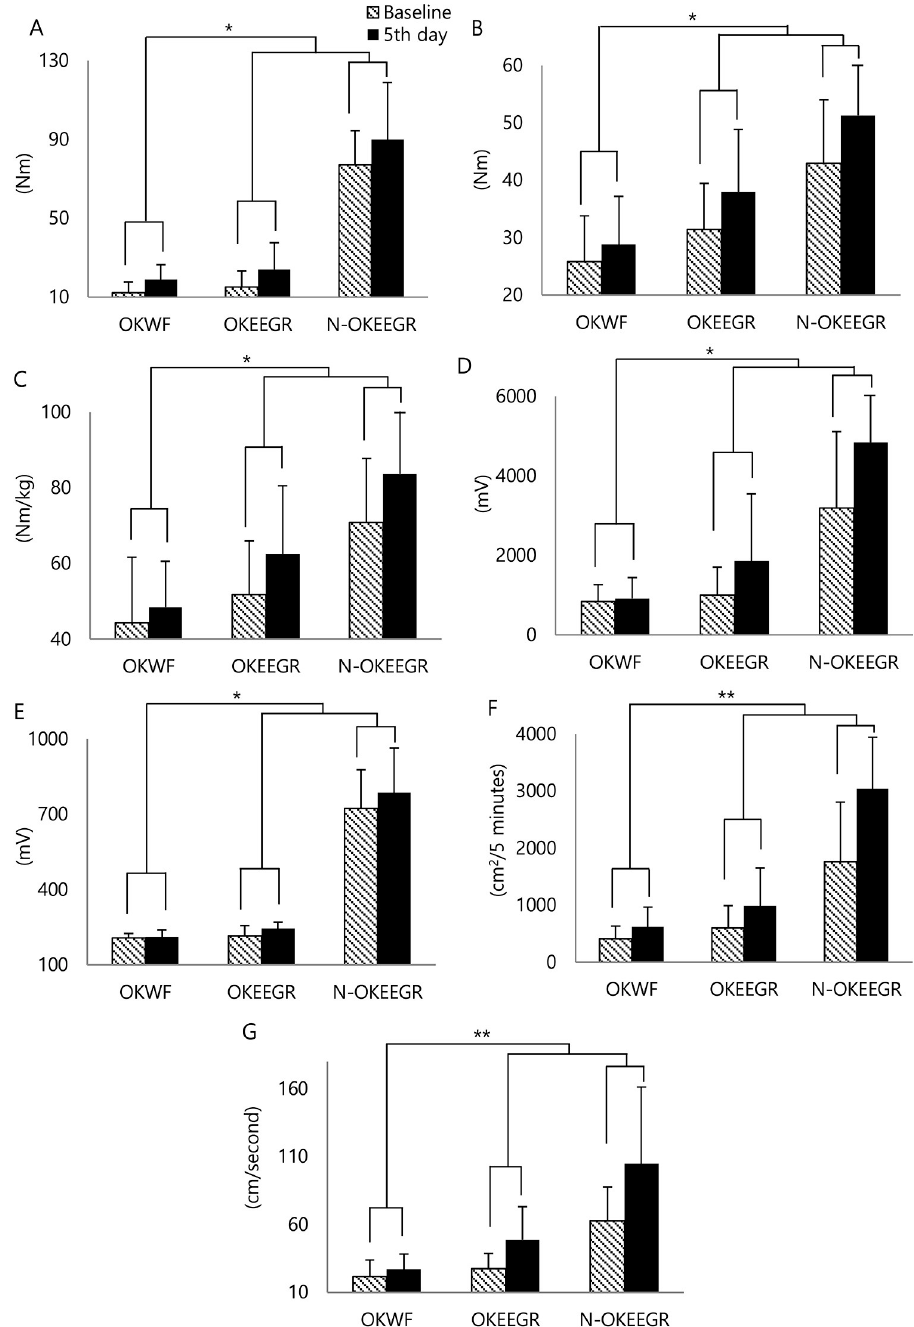
Fig 3. The peak torque and electromyographic muscle activation of knee flexors and extensors. Compared with the operated knees in the WF group (OKWF), the operated knees in the EEGR group (OKEEGR) and the non-operated knees in the EEGR group (N-OKEEGR) showed more improvement in (A) the peak torque of the knee extensors, (B) the peak torque of the knee flexors, (C) the peak torque of knee flexors/body weight, (D) the peak amplitude of the vastus medialis, (E) the mean amplitude of the biceps femoris, (F) the total area of the vastus medialis, and (G) the mean area of the vastus medialis. � p < 0.05, �� p < 0.01 by two-way repeated measures analysis of variance or paired T-